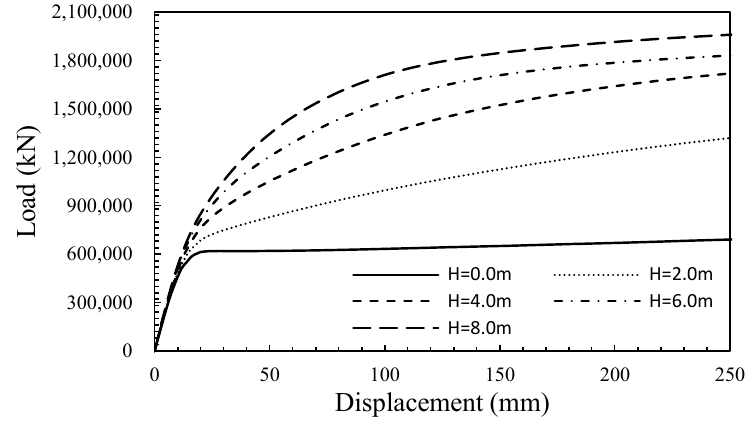
Figure 6. Load–horizontal displacement curve with enlarged height.